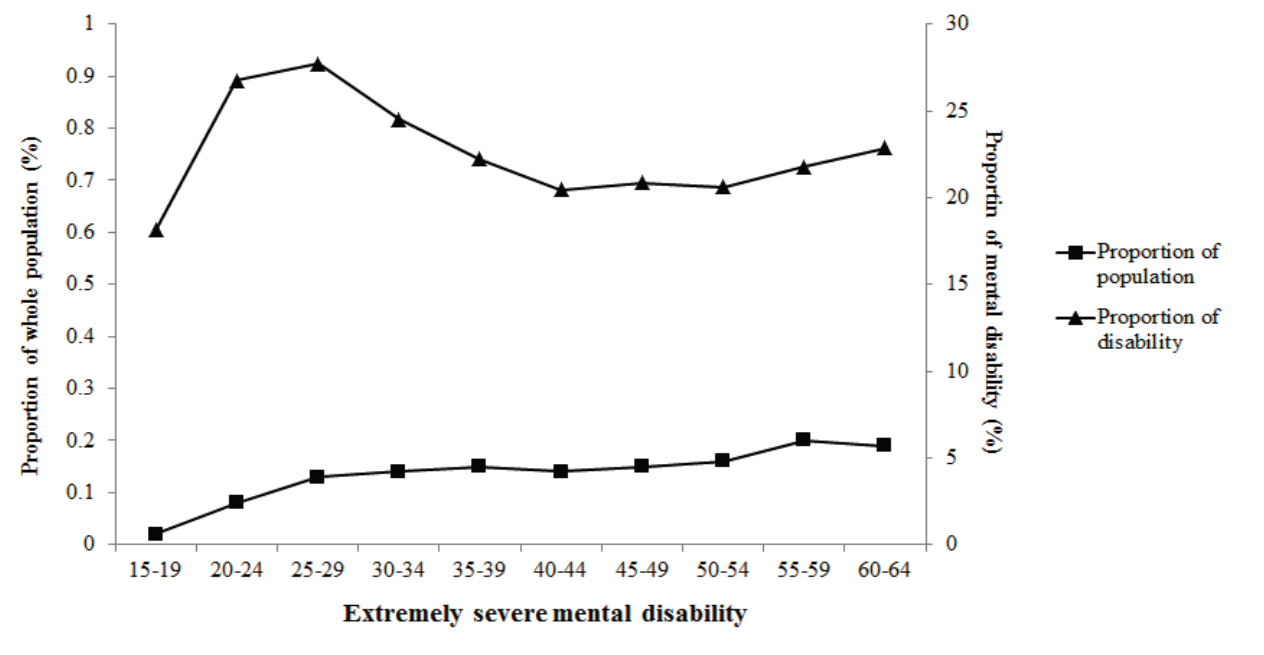
Figure 6. Proportion of extremely severe mental disability in different age groups.